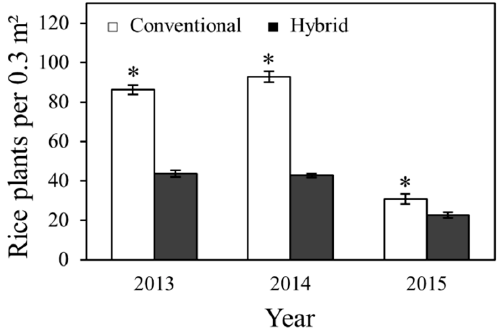
Figure 1. Mean rice stand per 0.3 m 2 (±SEM) of conventional and hybrid varieties in 2013, 2014, and 2015. An asterisk denotes a significant main effect of variety ( P < 0.05; Tukey’s